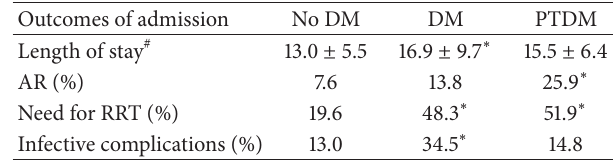
Table 2: Point of care capillary blood glucose levels. Table 3: Outcomes of transplant